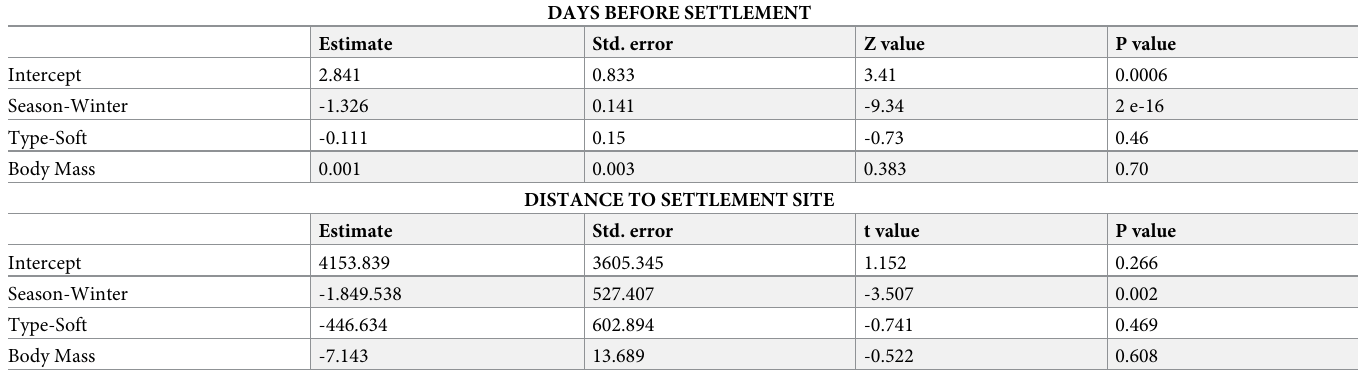
Table 2. Estimate regression parameters, standard errors, z values and P values for the generalized linear to examine the effect of season (fall or winter), type of release, and body mass on two response variables: Time to settlement (d) and distance to settlement (m) from release